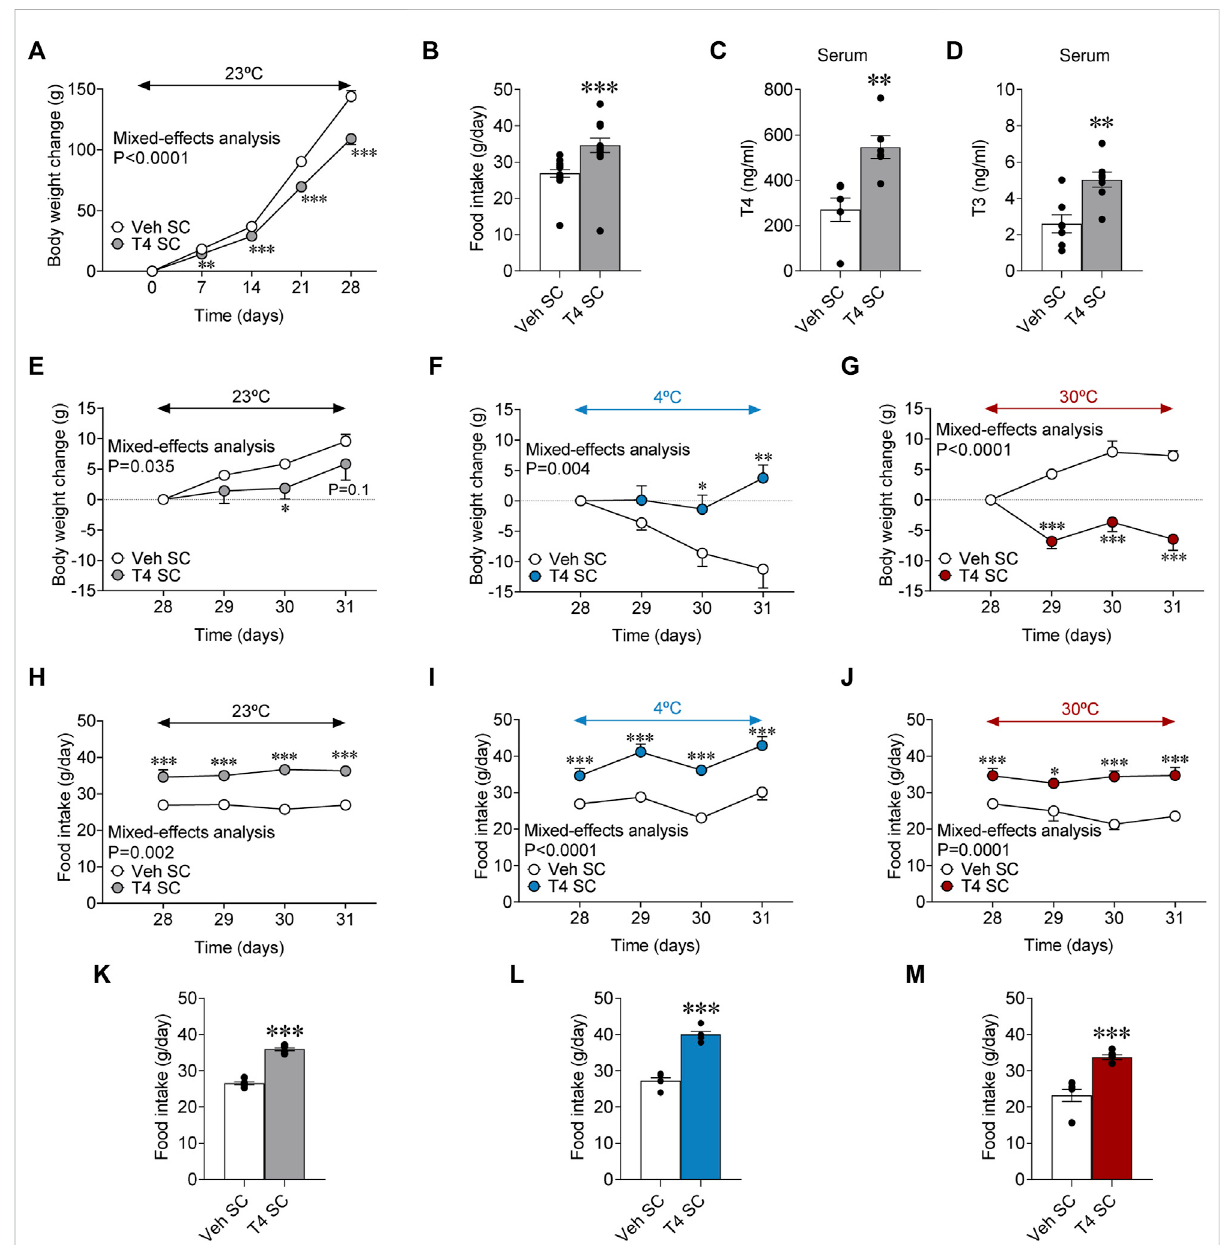
FIGURE 1 Effects of temperature on energy balance in hyperthyroid rats (A) Body weight change, (B) daily food intake, (C) serum T4 and (D) serum T3 in euthyroid and hyperthyroid rats [peripherally treated (SC)with vehicleorT4]. (E – G) Body weight change, (H,I) foodintake, and (K,L) daily food intake of euthyroid, and hyperthyroid rats housed at 23 ° C (E,H,K) , 4 ° C (F,I,L) or 30 ° C (G,J,M) . Data are represented as MEAN ± SEM. n = 23 – 24 (A,B) and 6 – 8rats/group (C – M) .Statistical signi fi cance was determined byMixedeffect analysis or Student ’ s t -test.* p < 0.05, ** p < 0.01,*** p < 0.001 vs. vehicle